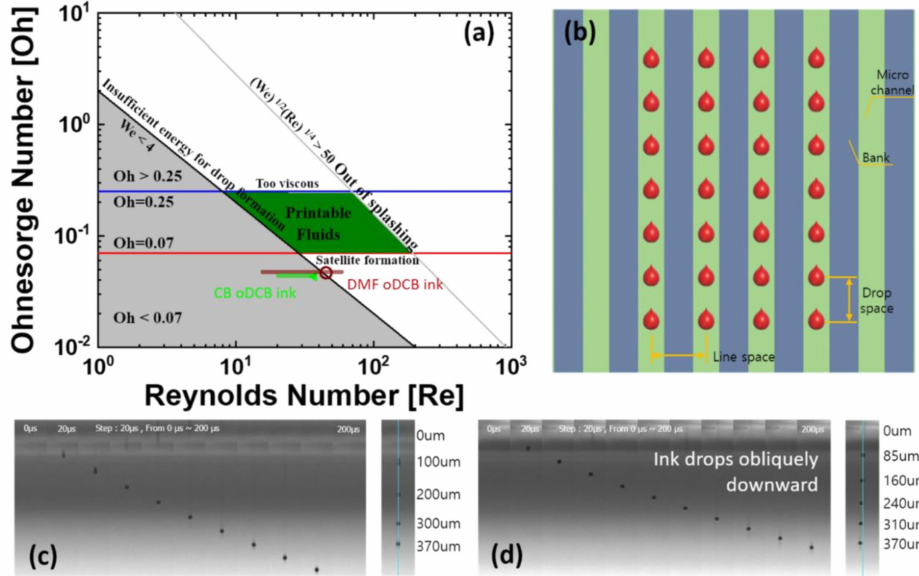
Figure 2. ( a ) Ohnesorge map of the area of the printable fluid and dimensionless numbers of produced co-solvented inks ( b ) schematic diagram of inkjet-printed drop positions onto microchannel. Ink drop images with co-solvented ( c ) with DMF and oDCB ink, and ( d ) with CB and oDCB